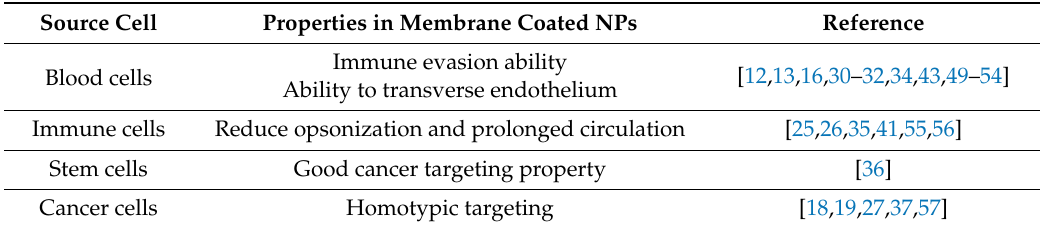
Table 1. Different source cells and their membrane-coating